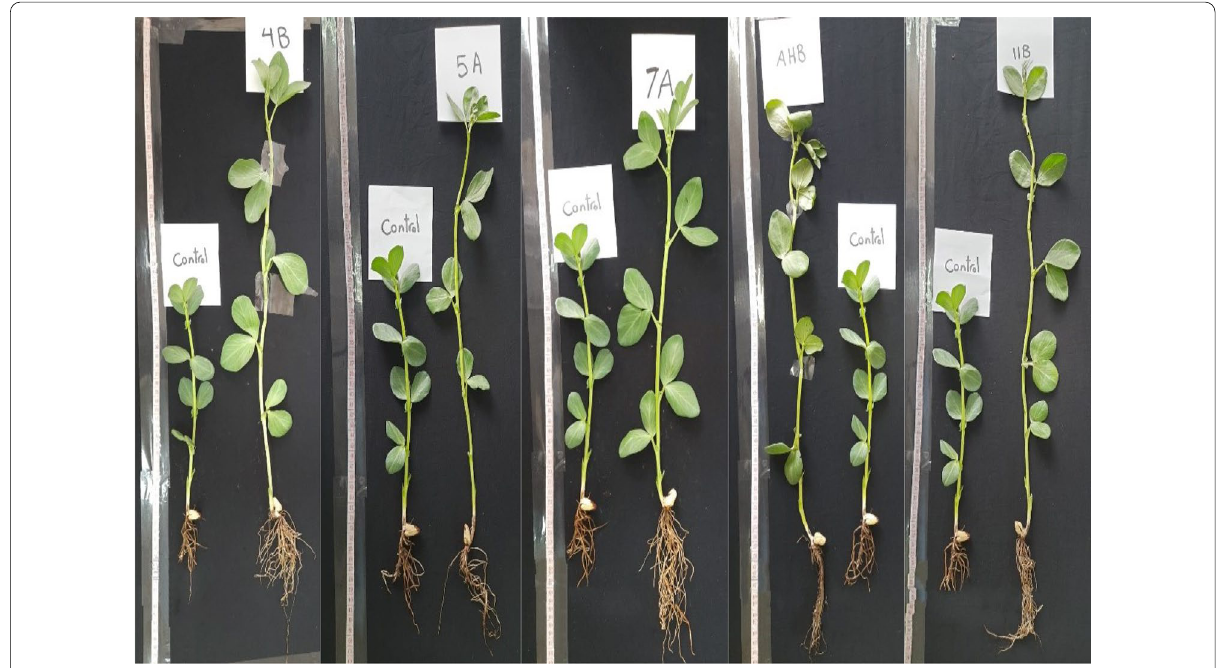
Fig. 3 Comparison between growth of treated seedlings and control after 28 days of regular irrigation in pot experiment